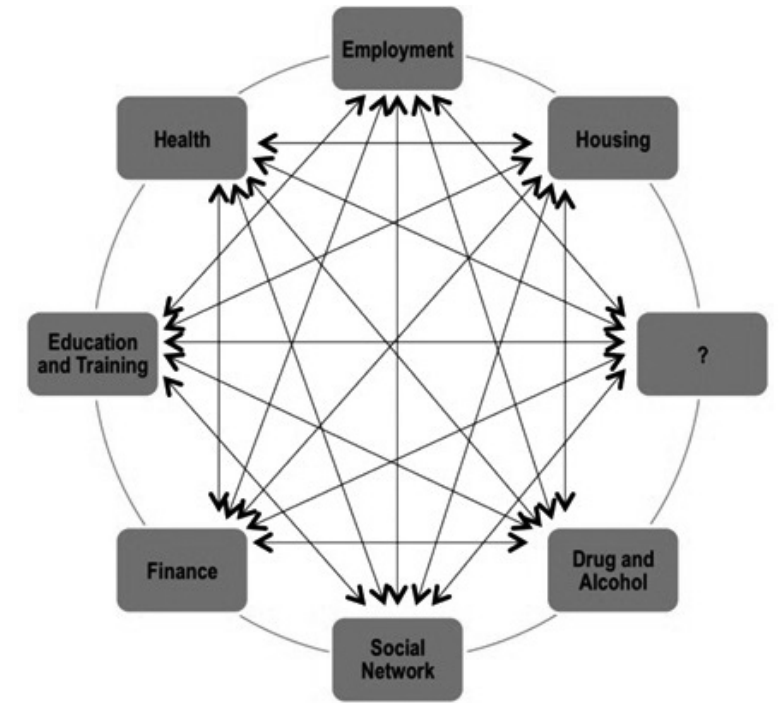
Figure 2: Example of a local integrated support